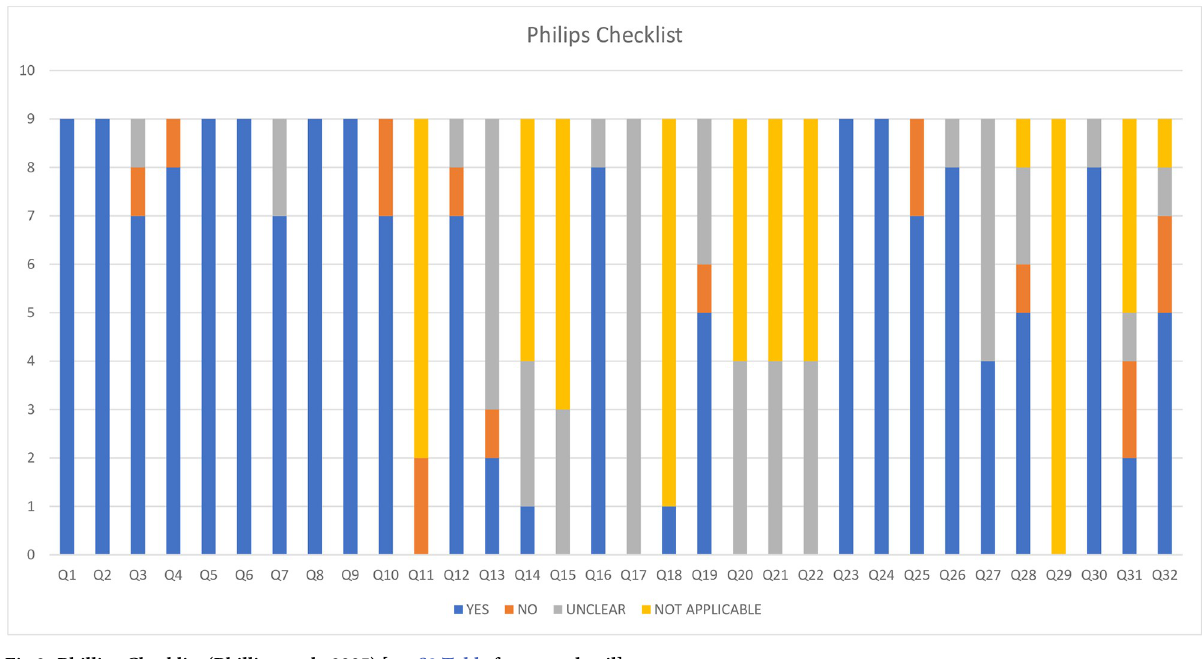
Fig 3. Phillips Checklist (Phillips et al.; 2005) [see S3 Table for more detail].